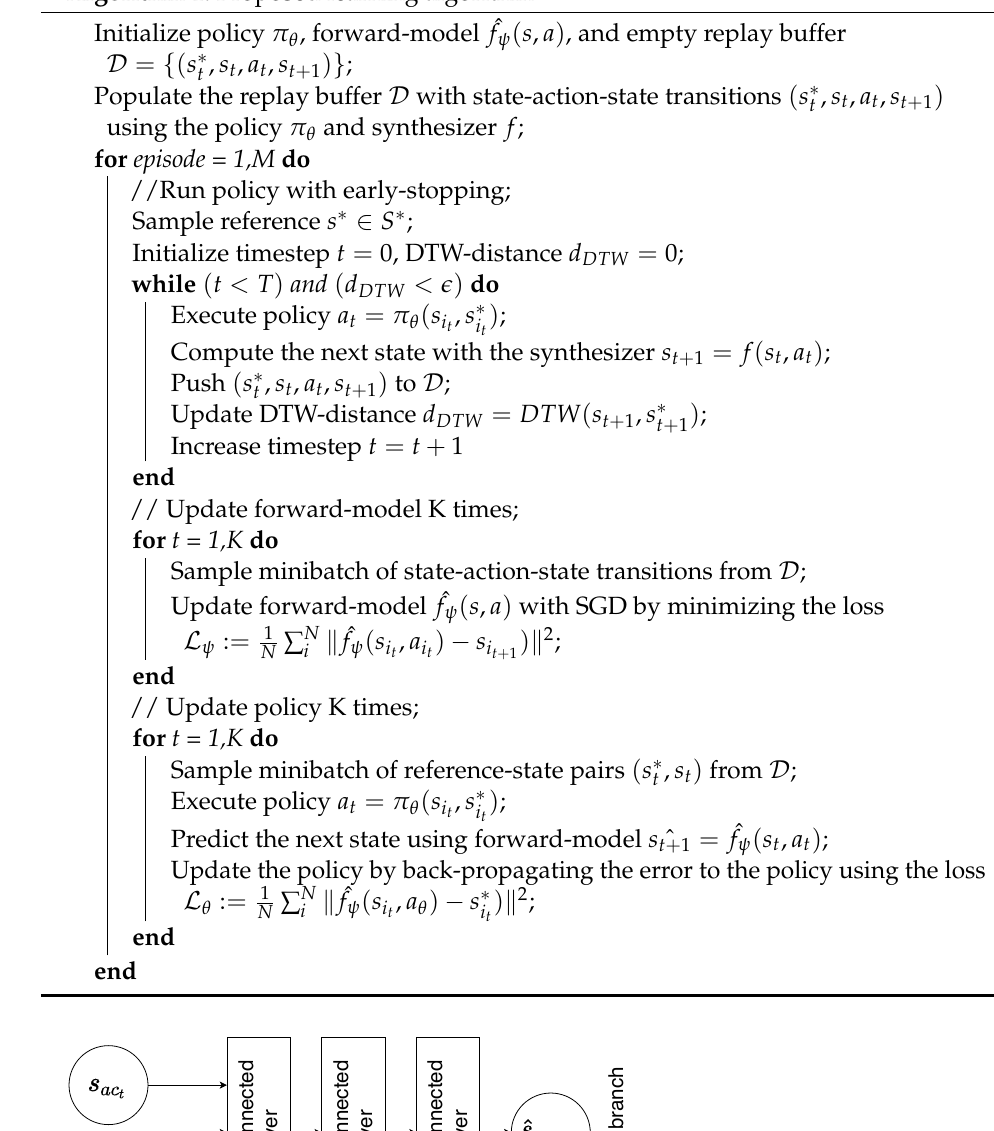
Algorithm 1: Proposed learning algorithm